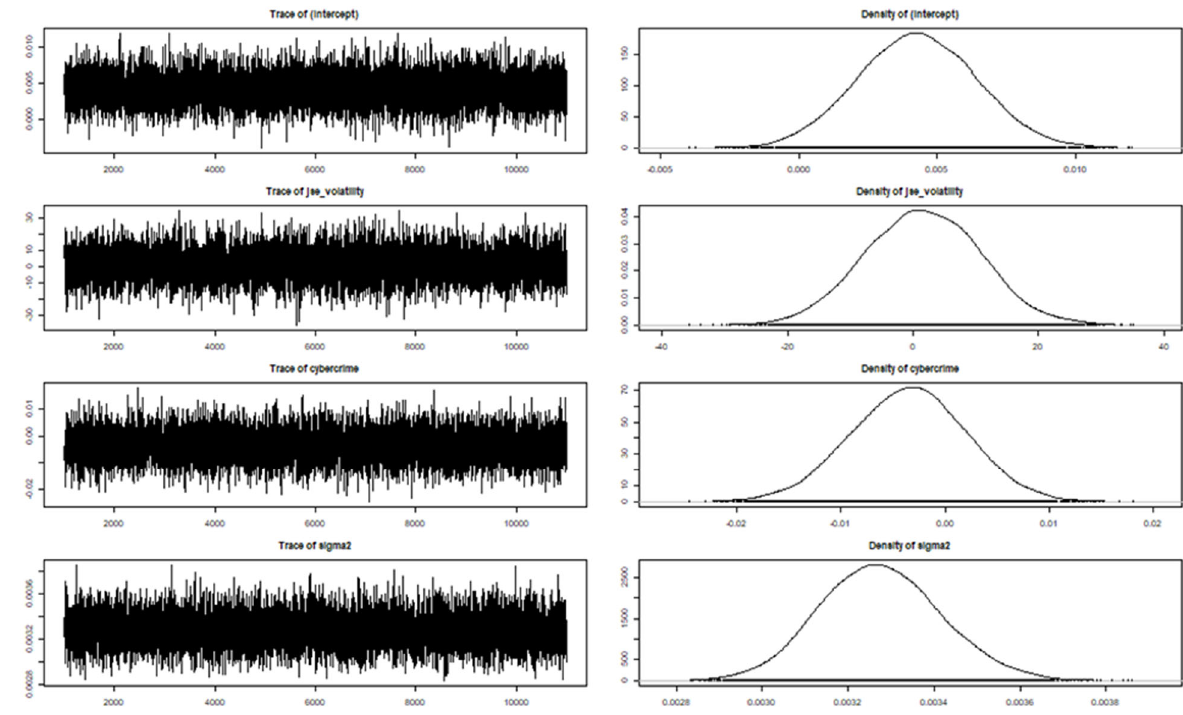
Figure 7. Posterior distribution of the variables with return on BNB as dependent variable. Table 3. BLR results with Return on Bitcoin as dependent variable.